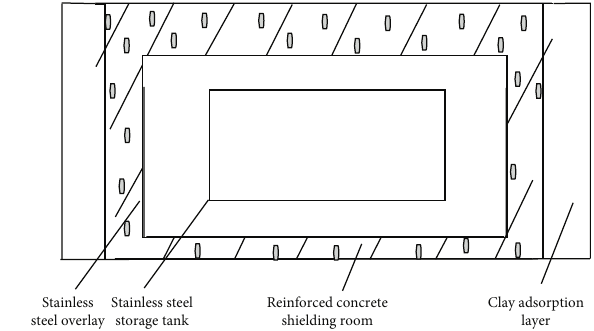
Figure 3: Four protective layers for high-level liquid waste storage tanks.